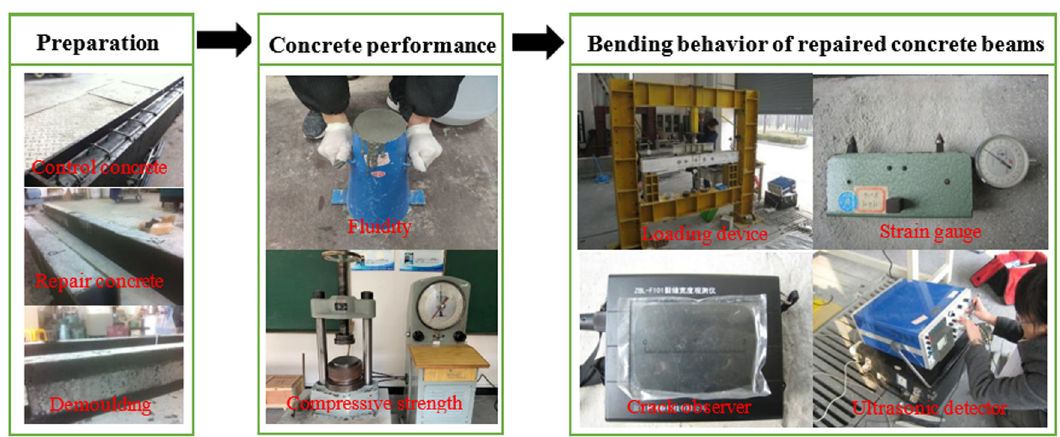
Figure 1: Test process.